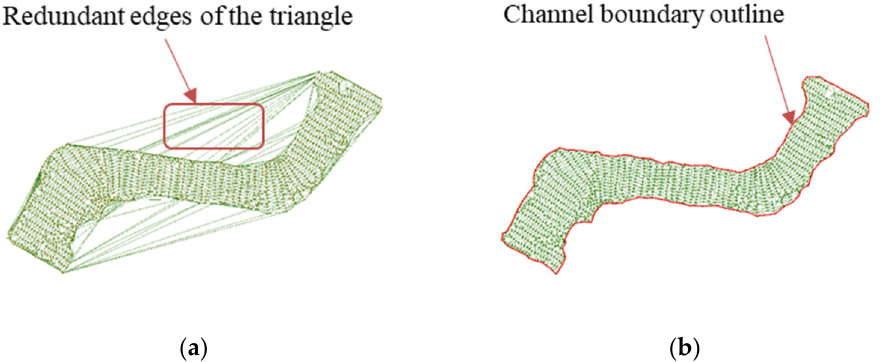
Figure 3. CDT–alpha-shape boundary extraction of waterway. ( a ) Triangulation of CDT, ( b ) alpha- shape contour extraction.